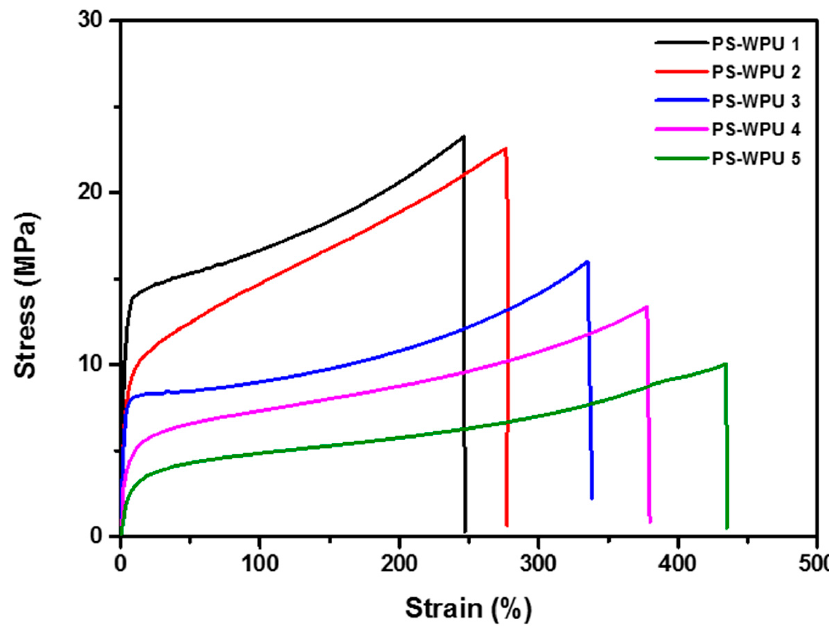
Figure 7. Stress–strain curves of PS-WPU samples obtained at room temperature. Table 5. Mechanical properties of PS-WPU samples.